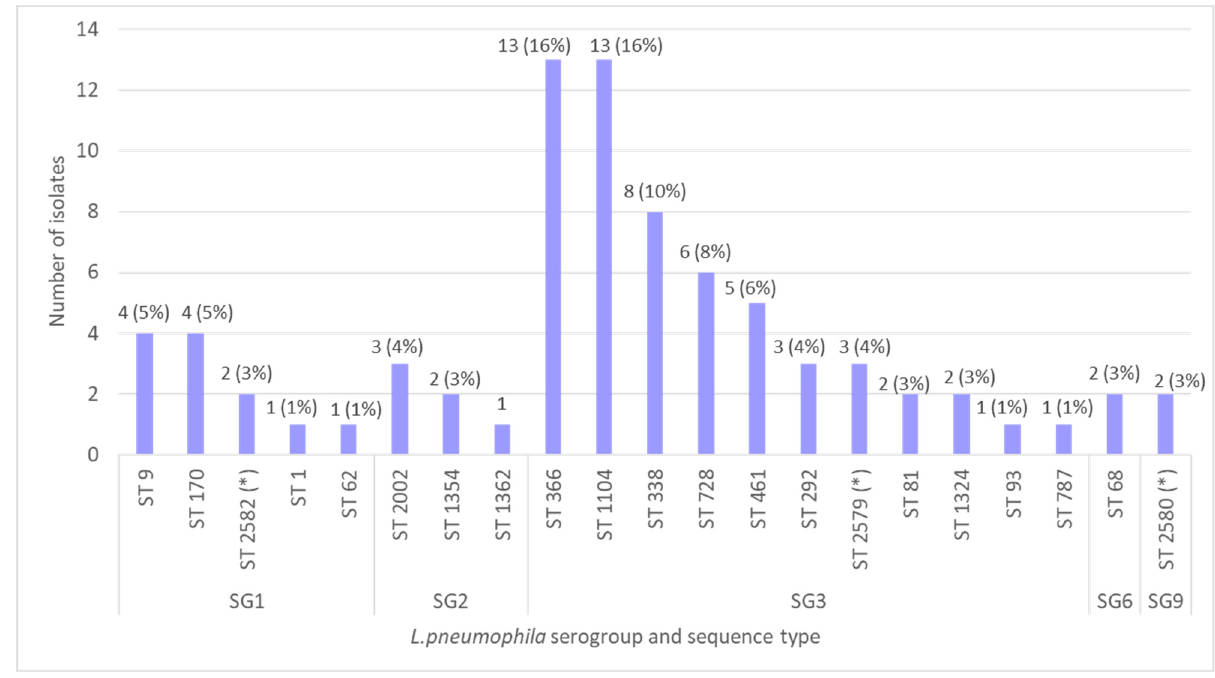
Figure 1. The distribution of L. pneumophila serogroups and sequence types in water samples from hotels (*—new sequence types)